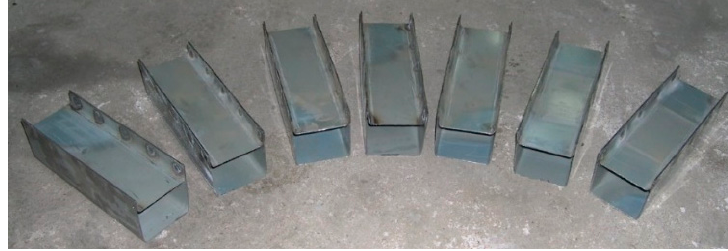
Figure 8. T1 specimens used in the quasi-static and dynamic experiments. The thin-walled 200 mm long element resembled the crumple zone elements used in vehicles, e.g., VW Polo, in terms of cross-section shape, structure, and assembly technique. Measurements of the specimen cross-section and layout scheme of the spot-welded joints are presented in Figure 9. A symmetrical layout of spot-welded joints was used for the specimen. The specimen had 10 spot-welded joints.